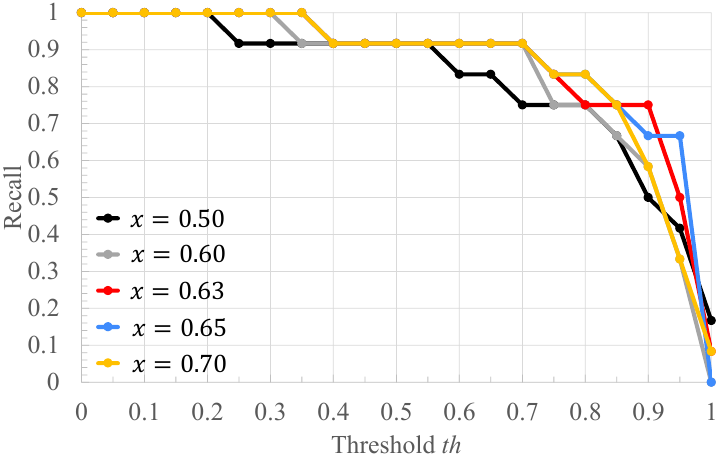
Figure 6. The recall of the proposed method when the threshold x used for RRI classification is varied.